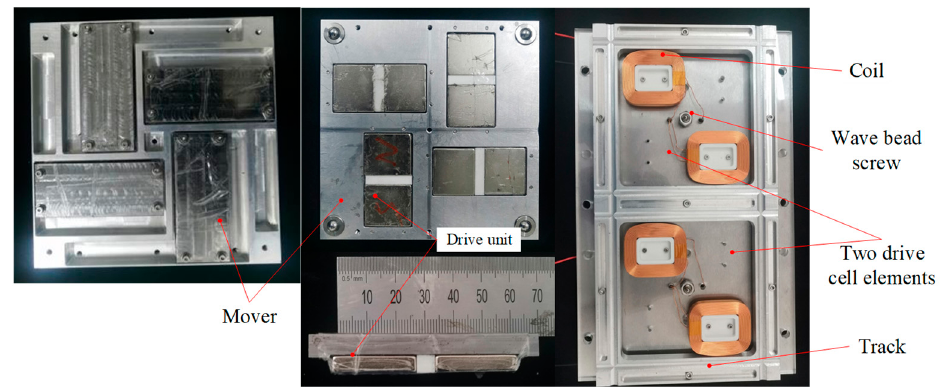
Figure 13. Prototype of the conveying platform.